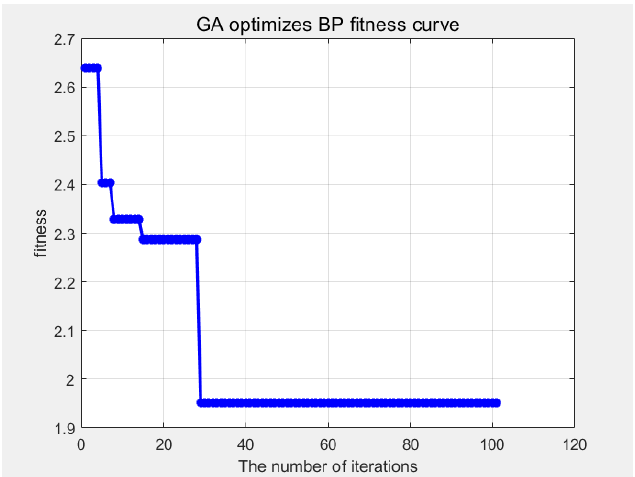
Figure 9. GA optimizes BP fitness curve.